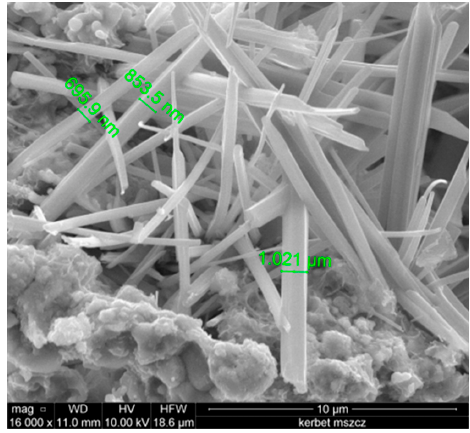
Figure 9. Needle-shaped etryngite.